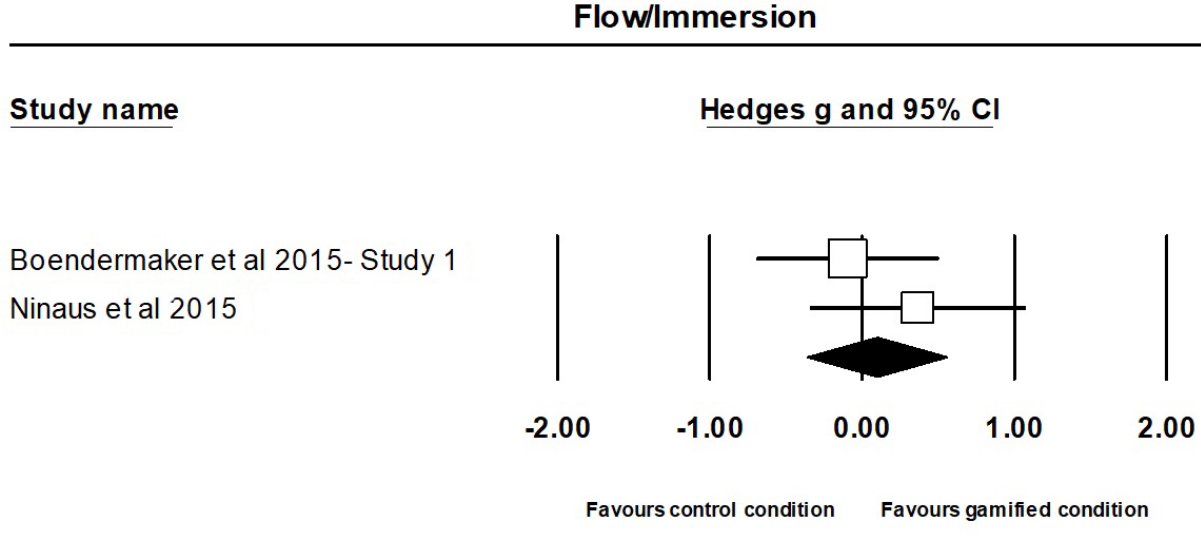
Figure 3. Forest plot of overall effect sizes comparing gamified condition and control condition (ie, non- or less-gamified version) on flow/immersion for individual studies in alphabetical